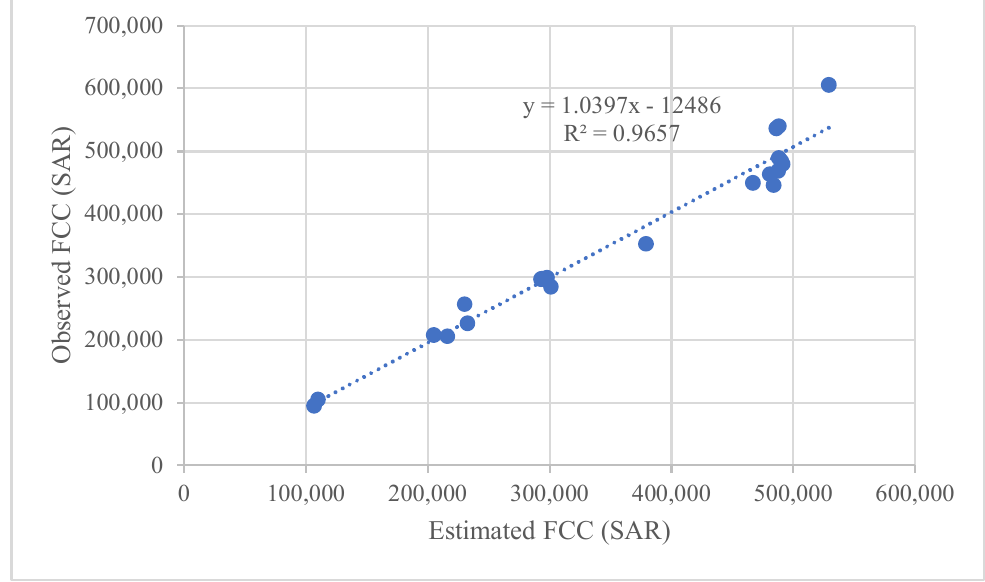
Figure 8. Correlation between estimated FCC and observed FCC .